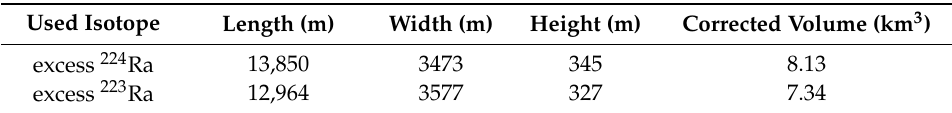
Figure 2. Local bathymetry of Brothers volcano (2-fold exaggeration) with the calculated plume ellipsoid for ex 224 Ra marked in yellow. Red dots indicate sample locations with excess 224 Ra activity above background level, which were used for the ellipsoid calculation. The black triangle marks the mean x and y location of plume samples (depth not representative for display reasons), which was used as ellipsoid center. The direction of view in the upper panel is westwards, and northeastwards in the lower panel. Local bathymetry from Koschinsky et al. [53]. Table 3. Comparison of calculated plume ellipsoids dimensions and volumes based on excess 224 Ra and excess 223 Ra activity above background levels. The volume is corrected for any overlap of the plume ellipsoid with local topography (i.e., caldera